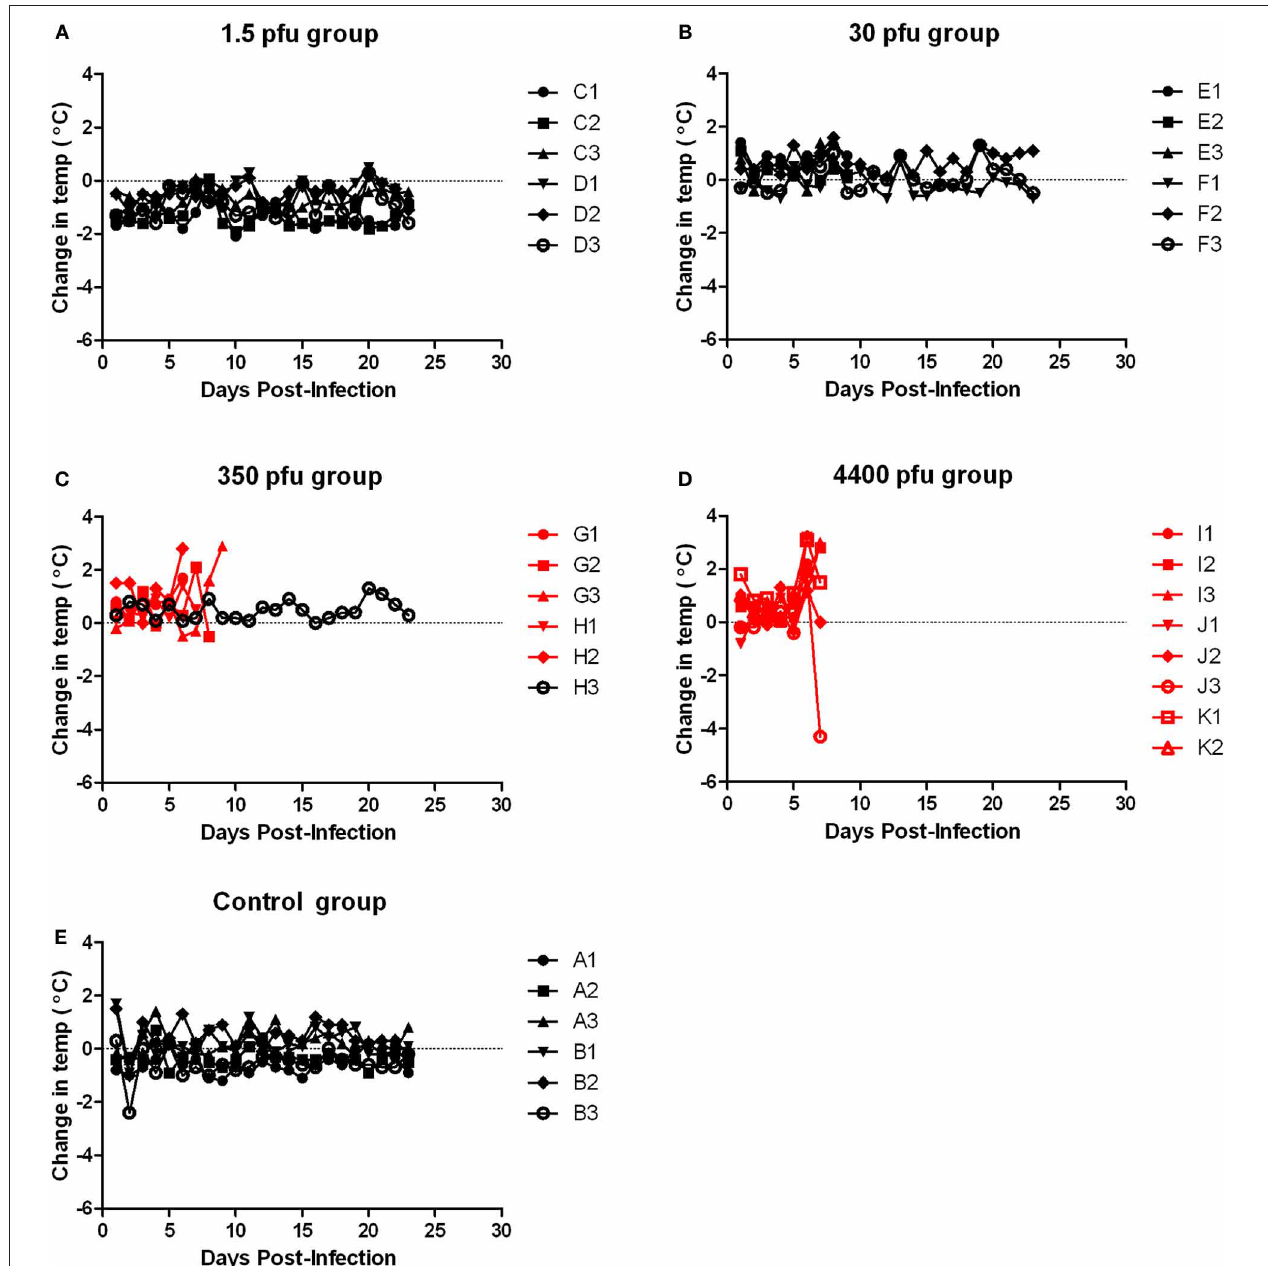
FIGURE 9 | Body temperature of Lewis rats infected with aerosolized RVFV. Groups of six to eight female Lewis rats were infected with RVFV by the aerosol route at four doses plus uninfected controls. (A) 1.5pfu/rat; (B) 30pfu/rat; (C) 350pfu/rat; (D) 4400pfu/rat; (E) Uninfected control